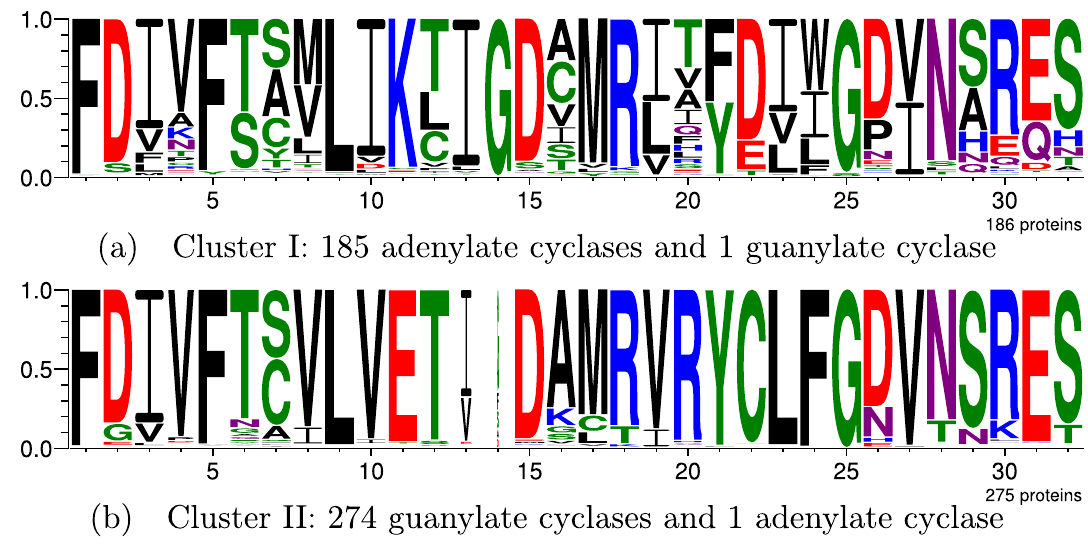
Fig 2. Nucleotidyl cyclase division into two clusters by the GP system. Subfigure (a) shows the active site logo for the adenylate cyclase cluster, while (b) shows that for the guanylate cyclase cluster.